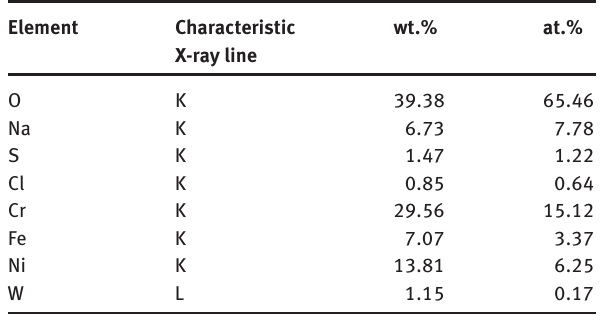
Table 7: Composition of globular grain by SEM/EDS [21]. Element